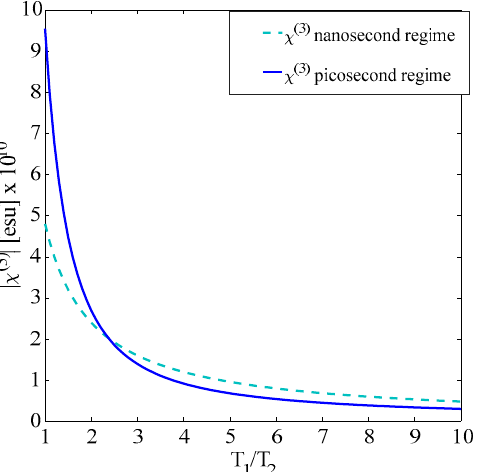
Figure 8. Numerical third-order nonlinear optical susceptibility vs. population loss factor T 1 / T 2 exhibited the SiNPs+N sample.